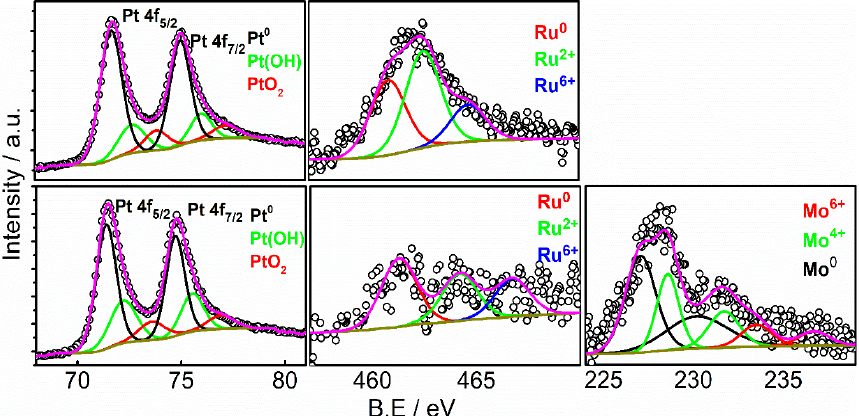
Figure 3. XPS spectra of the PtRu(TT)/C and Pt 2 RuMo(TT)/C catalysts annealed at 600 ◦ C measured with a photon energy of 1487 eV, by Al K α monochromator with a power of 20 eV, an energy step of 0.05 eV and an acquisition time of 100 ms, measured at room temperature.